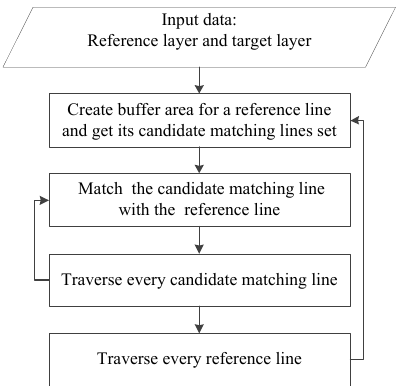
Figure 2: The flow chart of multi-scale line features matching